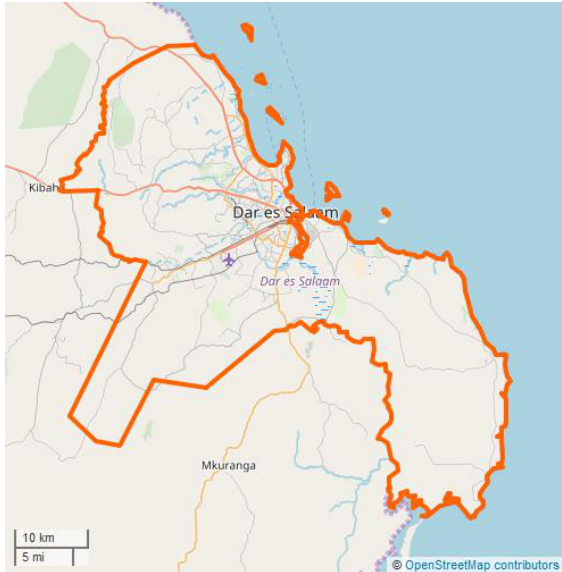
Figure 1. Study area: Dar es Salaam, Tanzania (map data © OpenStreetMap